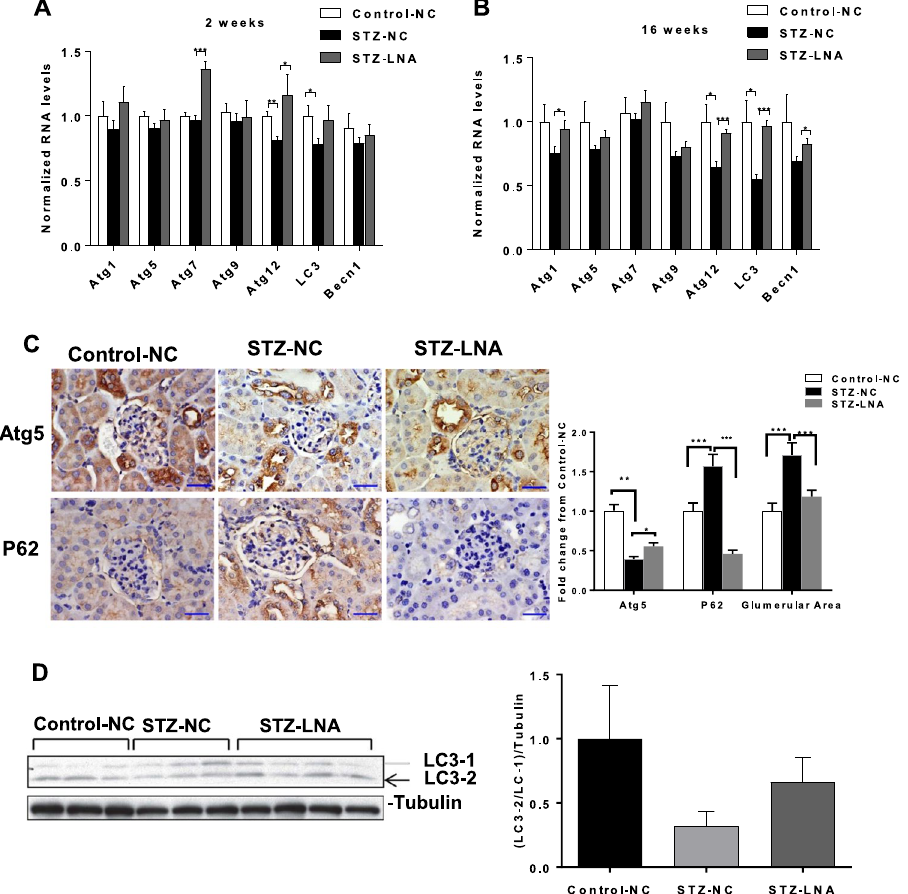
Figure 2. Decreased expression of autophagy genes in kidneys of STZ-injected diabetic mice relative to control mice and reversal of this effect on some genes with LNA-anti-miR-192 oligonucleotides.qRT-PCR analysis of autophagy genes in kidney cortex lysates from control (n = 3) and STZ-injected mice. ( A ) 2 weeks and ( B ) 16 weeks after induction of diabetes treated with either negative control (NC) (n = 3) or LNA-anti-miR-192 (LNA) oligonucleotides (n = 4). Scale bar, 20 µ m. x400 (10 × 40) magnification. ( C ) Representative immunostaining and quantification for Atg5 or p62 and glomerular area from cortical sections of control mice treated with NC oligonucleotides (Control-NC) (n = 3), STZ-injected diabetic mice treated with NC oligonucleotides (STZ-NC) (n = 3), and STZ-injected diabetic mice treated with LNA-anti-miR-192 oligonucleotides (STZ-LNA) (n = 4). ( D ) Western blot and quantification of LC3 levels (LC3-2/LC3-1) from kidney cortex lysates of Control-NC mice (n = 3), STZ-NC mice (n = 3), and STZ-LNA mice (n = 4) 16 weeks post diabetes induction. Uncropped scans are presented in Supplementary Fig. 1. * P < 0.05; ** P < 0.01; *** P <